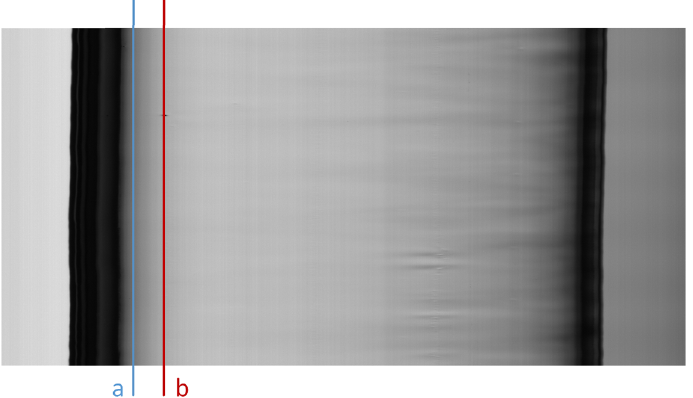
Figure 5. A frame with a blob defect. Column a is close to the edge of the tube and does not include a defect, column b includes a portion of a blob defect.